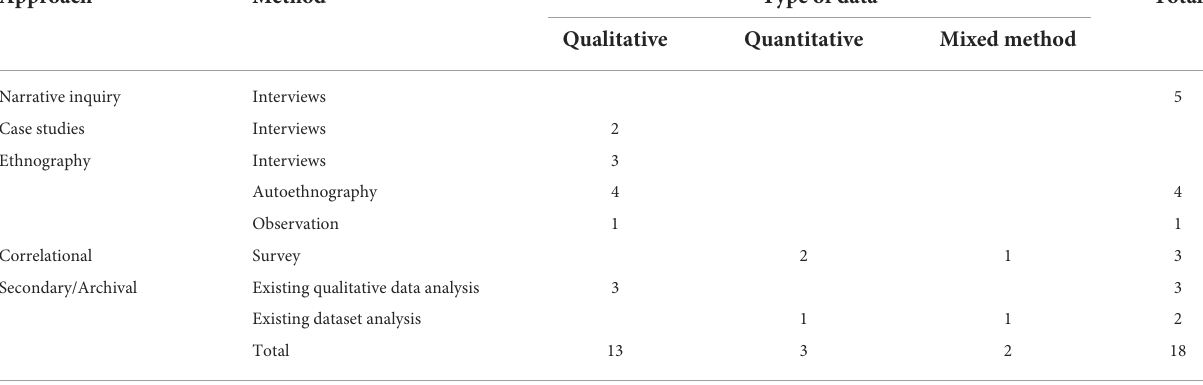
TABLE 4 Research design and primary method.